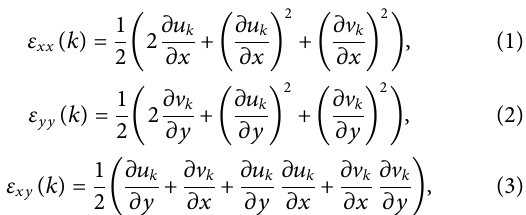
where u and v indicate the displacement fi eld along the x axis and y axis, respectively. The subscript “ k ” represents different scanning points: k = 2 , 3 , 4 , 5 , 6 , 7 . Then, the displacements were converted to three strain fi elds (normal strain fi eld ε xx , ε yy along the x axis and y axis, respectively, and shear strain fi eld ε xy ). The radial strain fi eld in different scanning steps is shown in Figure 4B . Deformation evolution involving localization changes in the SRM is indirectly probed by the fracture progressive process from those CT images. Owing to the interaction between the rock blocks and the soil matrix, shear and tensile damage co-exist during deformation. It is dif fi cult to observe such changes by the gray value method.